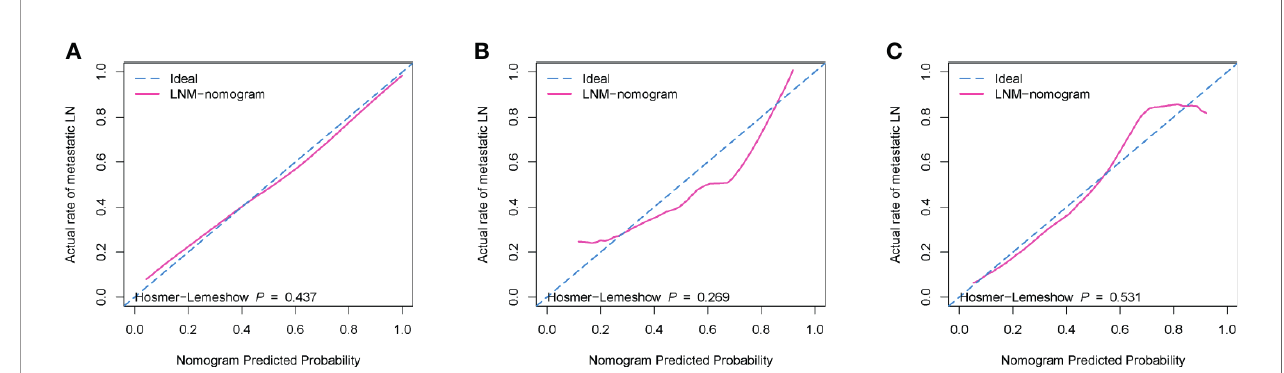
FIGURE 5 | The calibration curves with Hosmer – Lemeshow test of the nomogram (model 3). (A) Training cohort. (B) Internal validation cohort. (C) External validation cohort. The x-axis represents the predicted LNM risk, and the y-axis represents the actual probability of LNM. The closer the diagonal dotted blue line fi t is to the ideal line (the pink solid line), the better the predictive ability of the nomogram is.